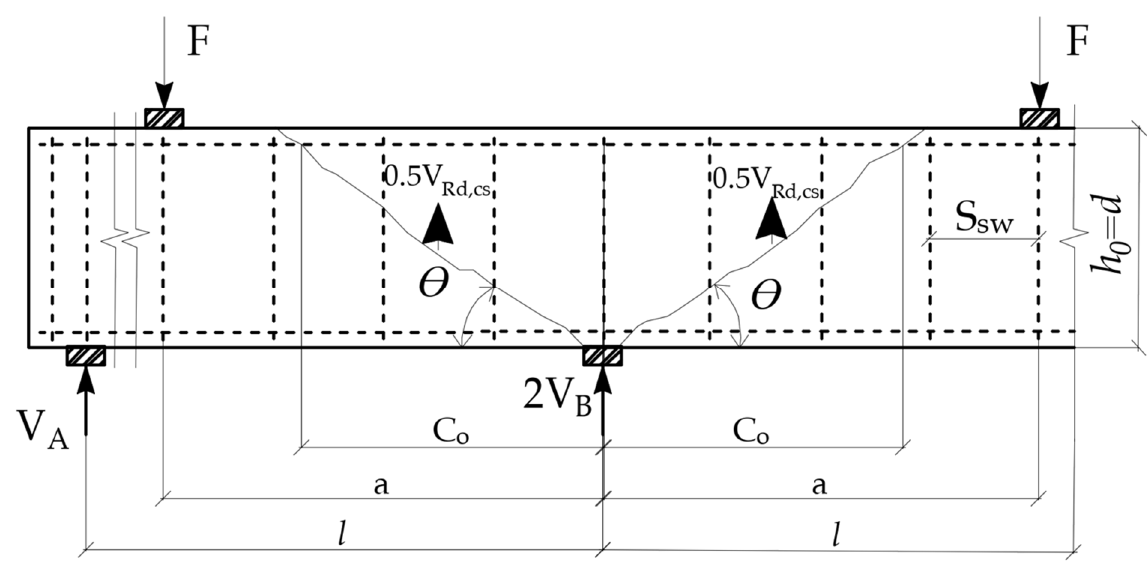
Figure 7. Diagram of the destruction of continuous reinforced concrete beams.